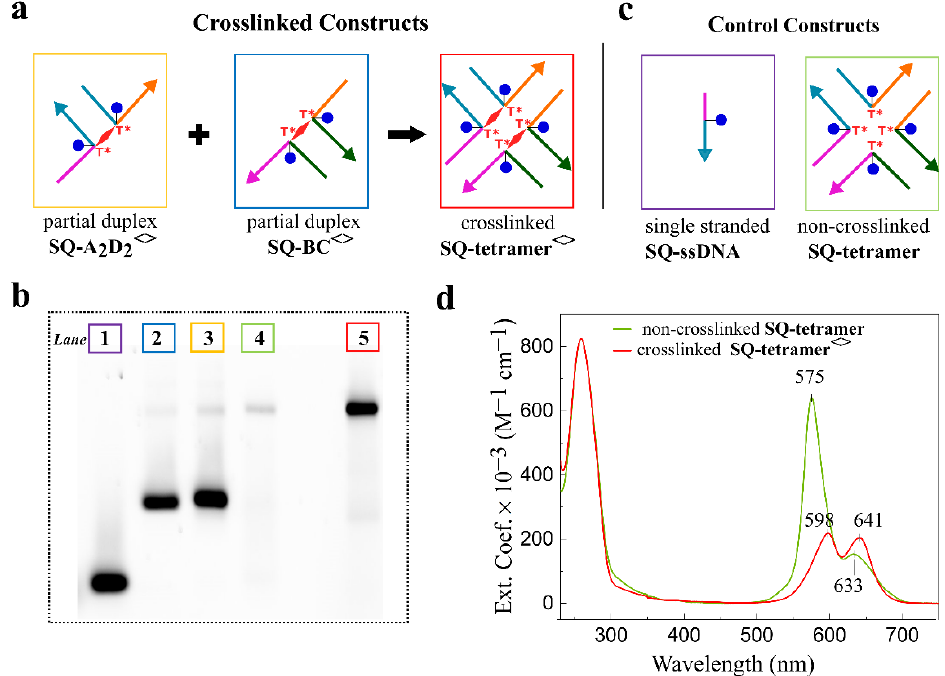
Figure 5. SQ-tetramer <> templated by a doubly crosslinked HJ. ( a ) Schematic representation of the assembly of SQ-tetramer <> from purified crosslinked partial duplexes. ( b ) Fluorescence image of non-denaturing PAGE (15%) of squaraine-DNA constructs. Lane numbers are color-coded to the boxes of DNA construct schematics. The samples were applied on the gel at 0.3 µM concentration. Note that band visibility in lane 4 is low due to strongly suppressed fluorescence in the non-crosslinked SQ-tetramer aggregate. ( c ) Schematics of the control constructs used to analyze the formation of crosslinked SQ-tetramer HJ. ( d ) Acquired steady-state absorption spectra of non-crosslinked SQ-tetramer and crosslinked SQ-tetramer <> in 1× TBE, 15 mM MgCl 2 at room temperature. The SQ-DNA concentrations were 1.5 μ M.